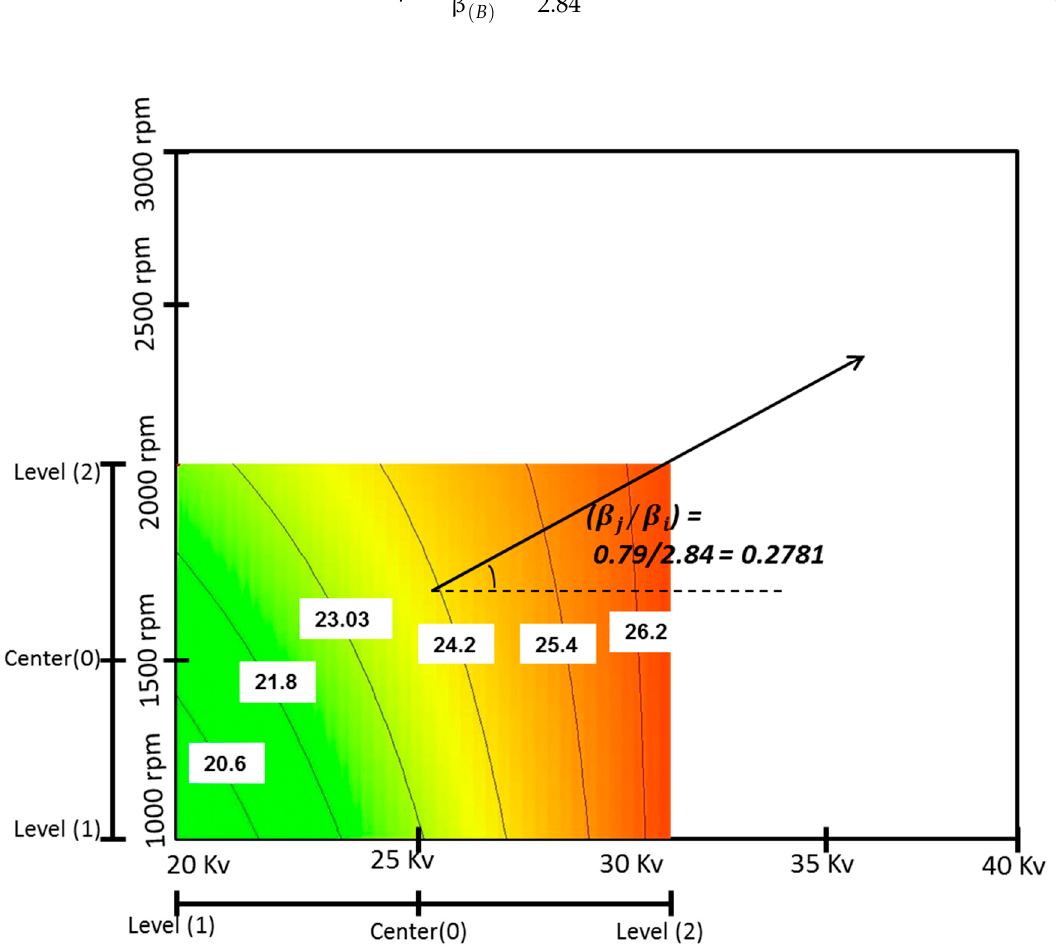
Figure 2. Pathway of steepest ascent method.